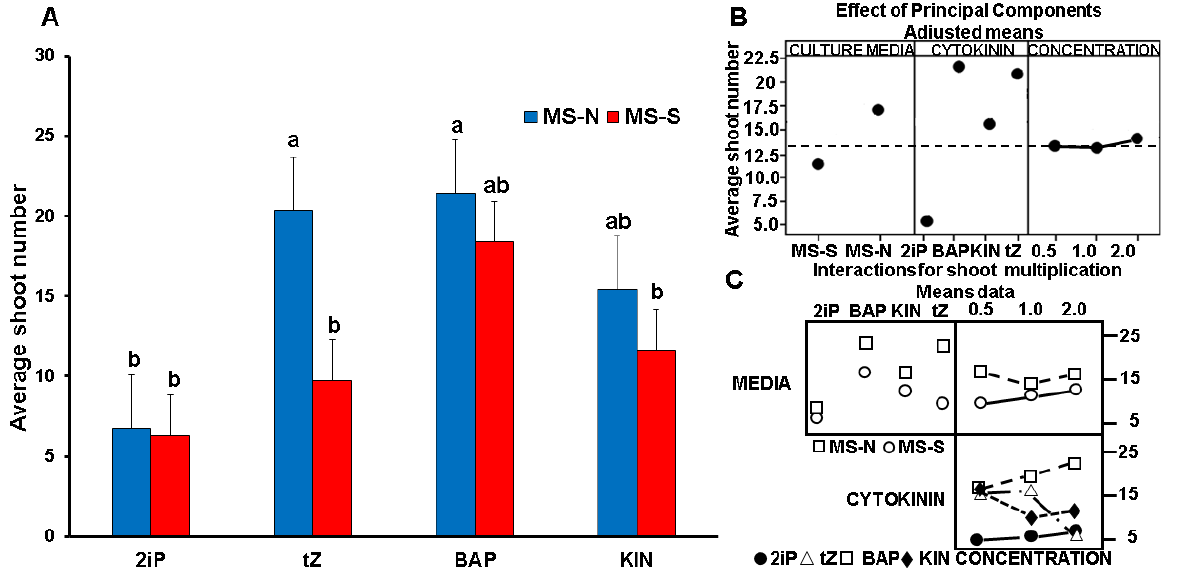
Figure 2. ( A ) Average shoot number of in vitro shoots produced after four weeks of culture on MS-N and MS-N with different CK types and concentrations. Results represent the average values of three independent replicates. The a, b, and c lowercase letters over the columns indicate the result of Tukey’s test ( p ≤ 0.05) after comparing the various treatments. ( B ) Representation of the multifactorial statistical analysis of variance on the main factors’ different effects in our experiment. ( C ) Result of the relationships of variables on plant shoot production.